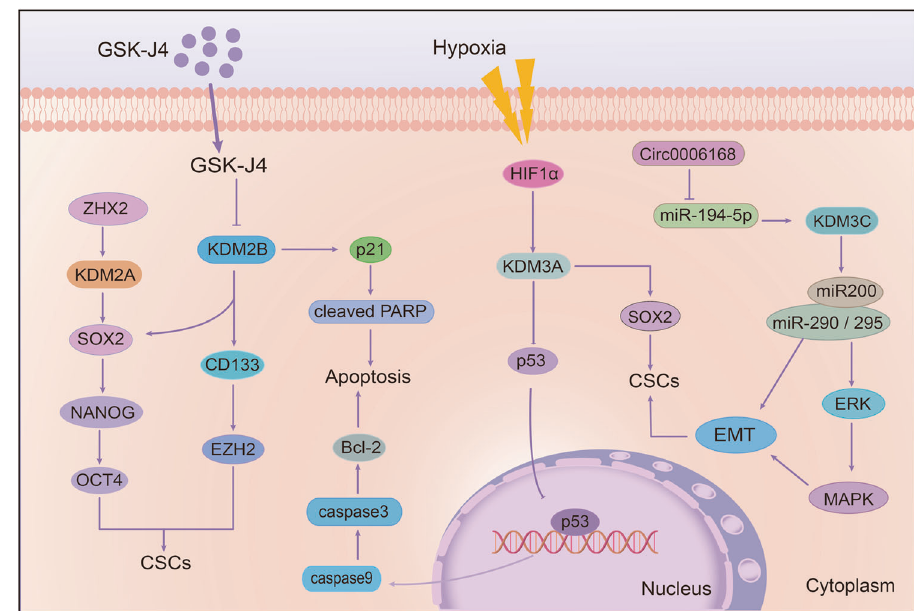
Fig. 9 The roles of KDM2 and KDM3 families on drug resistance. KDM2A can promote cell stemness by upregulating the expression of stemness markers Sox2 and Oct4. KDM2B can enhance drug resistance by increasing stem cells and apoptosis at the same time. In addition, KDM3A is able to decrease p53 expression at the transcriptional level and KDM3C can inhibit EMT through the ERK/MAPK signal pathway